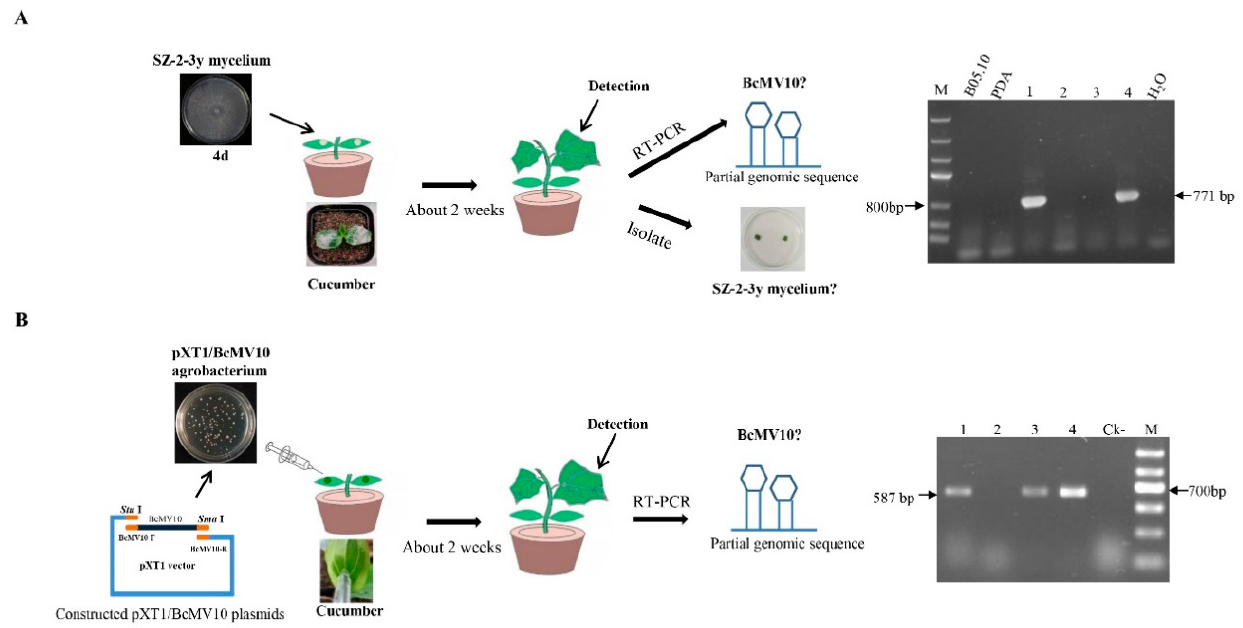
Figure 8. Schematic diagram of wound inoculation of cotyledons of cucumber plants with SZ-2-3y and RT-PCR detection of the BcMV10 sequence in new leaves of ‘Cuiyu’ plants inoculated with: ( A ) SZ-2-3y mycelia (M = Marker III, B05.10 mycelia and blank PDA-inoculated plants as negative controls; ( B ) agro-infiltration with the pXT1/BcMV10 clone (Ck- = pXT1-inoculated plants as negative controls; M-Marker II; Lanes 1–4, new leaves from four ‘Cuiyu’ cv. cucumber plants inoculated with SZ-2-3y mycelia ( A ) and pXT1/BcMV10 ( B ), respectively.